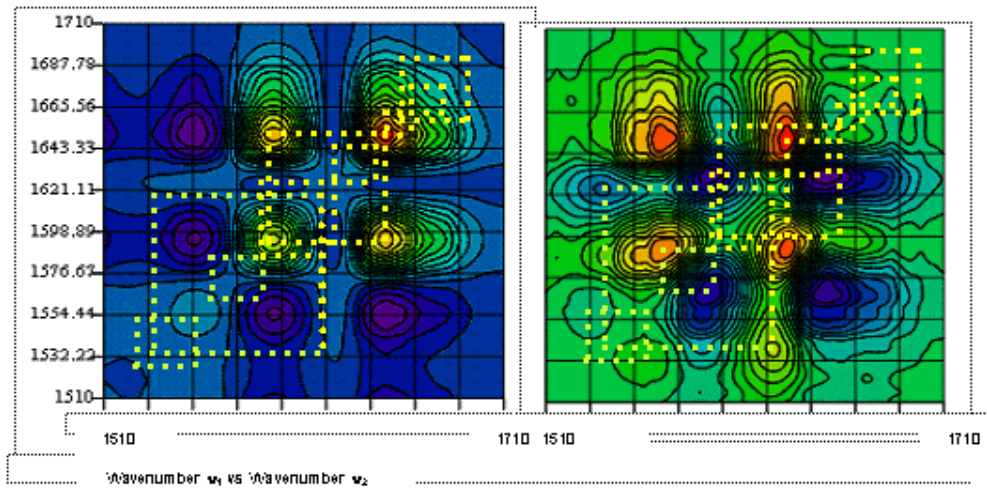
FIGURE 1. 2D correlational plots for the calcium titration experiment of Ccen; (a) synchronous and (b) asynchronous